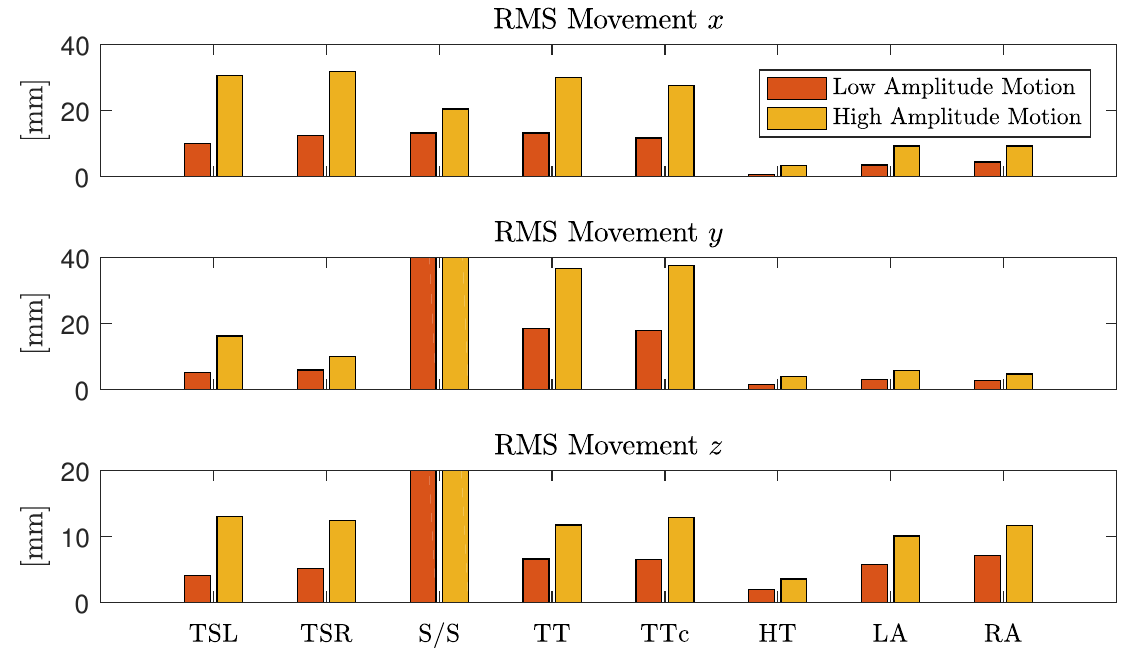
Figure 9. Motion amplitude for individual maneuvers averaged over all